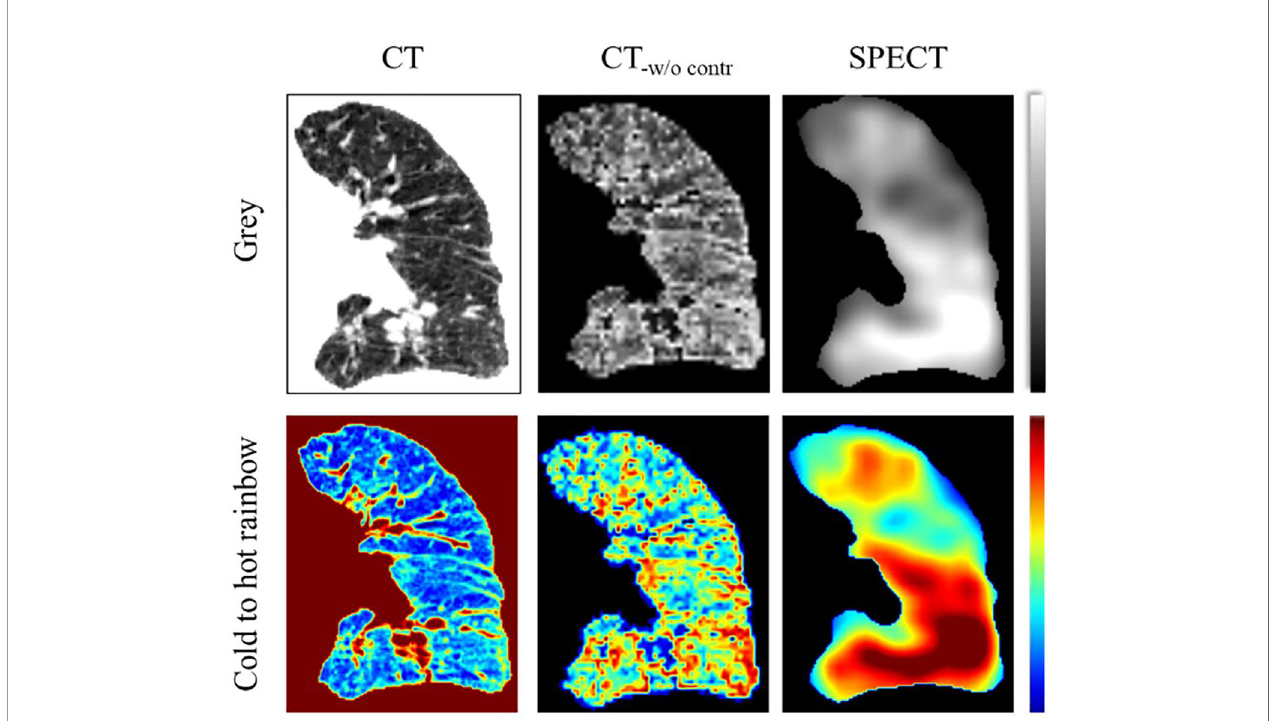
FIGURE 7 | Illustration of the CT contrast enhancement of a representative case in coronal view. The CT image was visualized in the range of − 1000 to 0. The SPECT image was visualized in the range of 0 to 800. CT -w/o contr is the CT image after contrast enhancement.